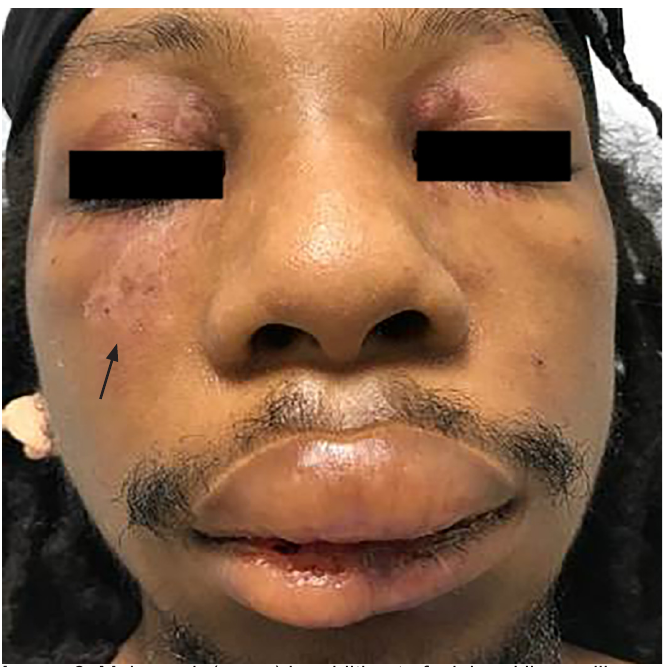
Image 3 . Malar rash (arrow) in addition to facial and lip swelling.